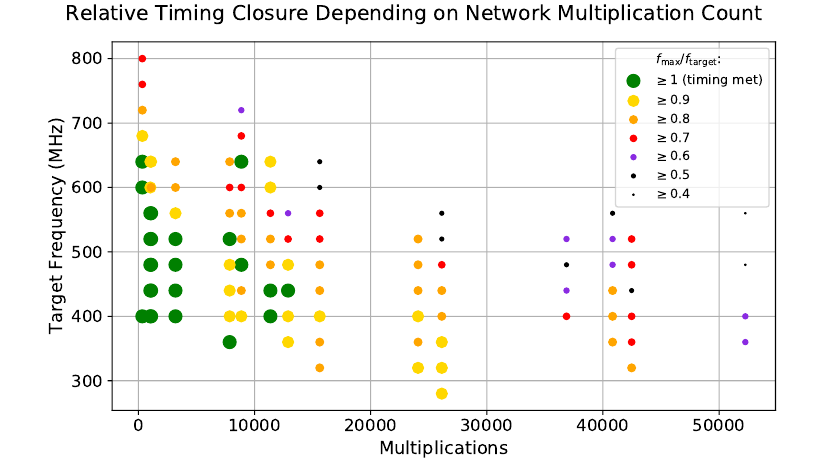
Figure 4. Plot showing the relative network timing closure depending on the network size (multiplica- tions) and the target frequency (multiple of the 40 MHz data frequency). Every column represents one example network.